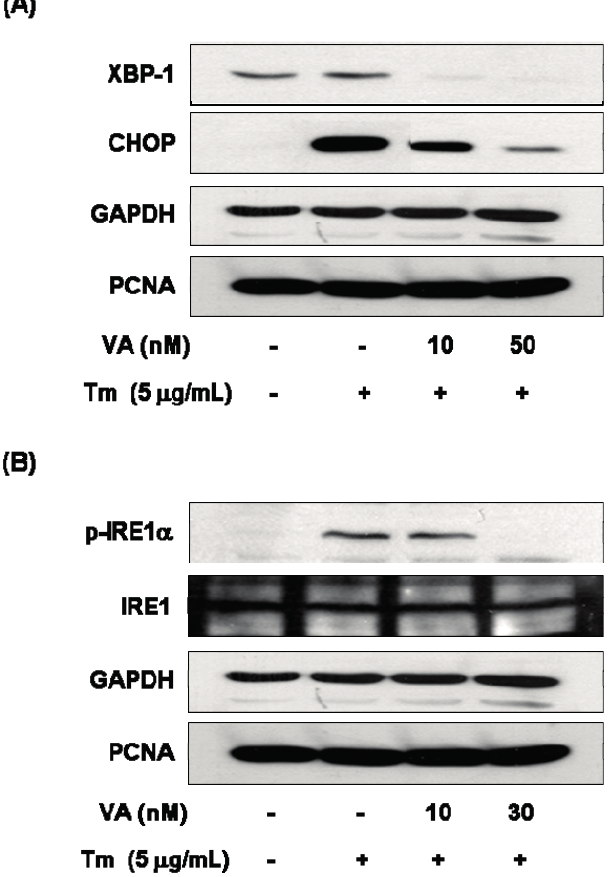
Figure 5. Verrucarin A inhibits ER stress in FaO cells. ( A , B ) Western blotting analysis. Tm-induced XBP-1, CHOP, IRE1 expression were inhibited by VA. Cells pre-treated with 0, 10, and 30 nM of VA or not with each dose for 1 h was exposed to 5 μ g·mL − 1 Tm for 6 h in FaO cells. (+): treated with Tm, ( − ): untreated